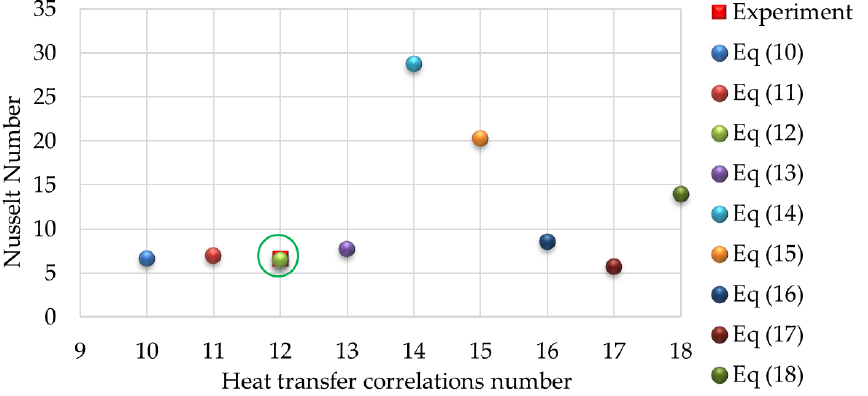
Figure 11. Correlation for empty channel (flow rate = 5 L/m).